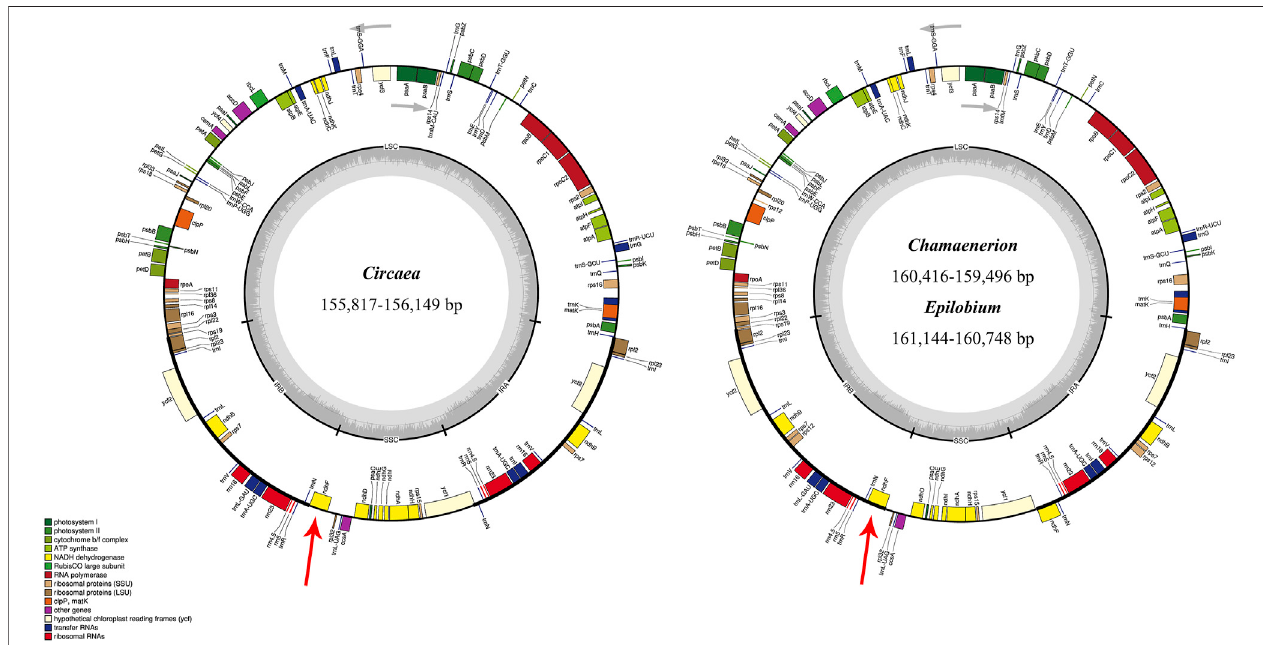
FIGURE 1 | Chloroplast genome maps of Chamaenerion , Circaea , and Epilobium sampled in the present study. Thick lines on the outer circle identify inverted repeatregions(IRaandIRb).TheinnermosttrackindicatestheG+Ccontent.Genesontheoutsideofthemaparetranscribedinaclockwisedirection,andgenesonthe insideofthemaparetranscribedinacounterclockwisedirection.IR,invertedrepeat;LSC,largesinglecopy;SSC,smallsinglecopy.RedarrowsshowedthedifferentIR- SC boundaries between the two chloroplast genome